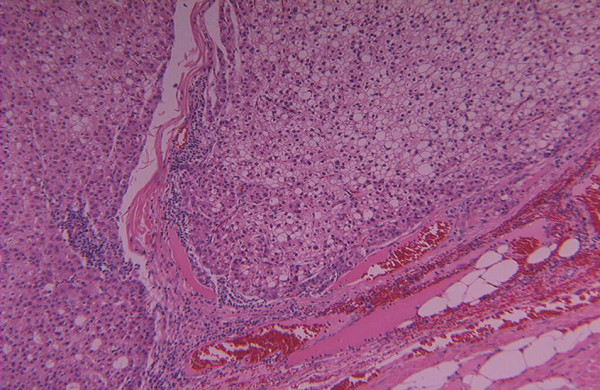
Histopathological examination of the excised mass. Shows that the tumour is made of thick hepatocyte cell plates with foci of acinar formation from the margins. (H&E stain, 10× HPF)